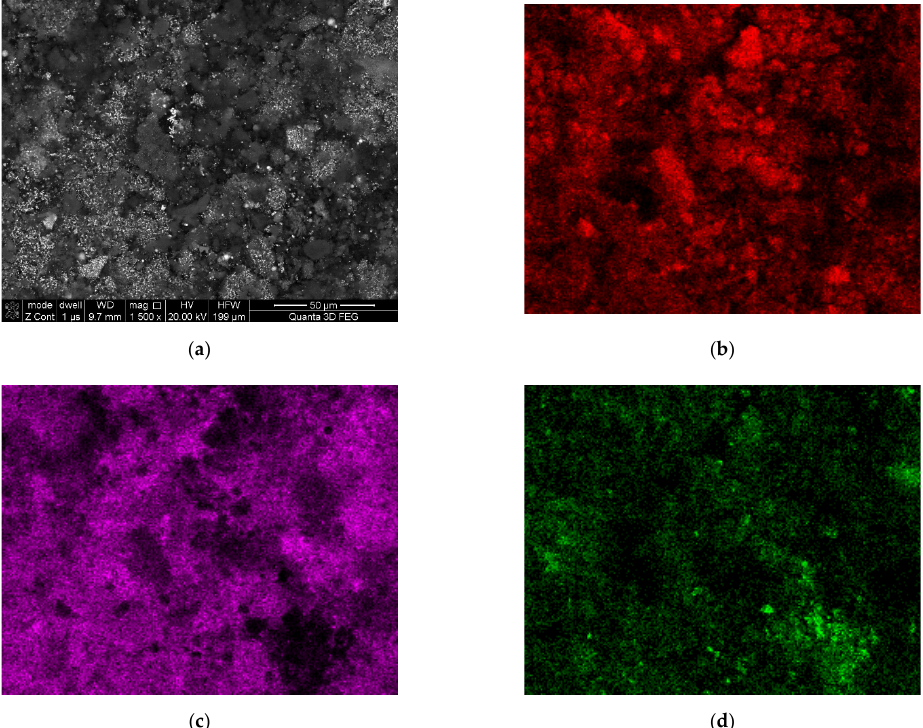
Figure 5. SEM image and EDS maps of element distributions on the surface of the used catalyst. Power—25 W. Temperature—500 °C. ( a ) Analyzed area. Magnification ×1500; ( b ) carbon; ( c ) cobalt; ( d ) oxygen.